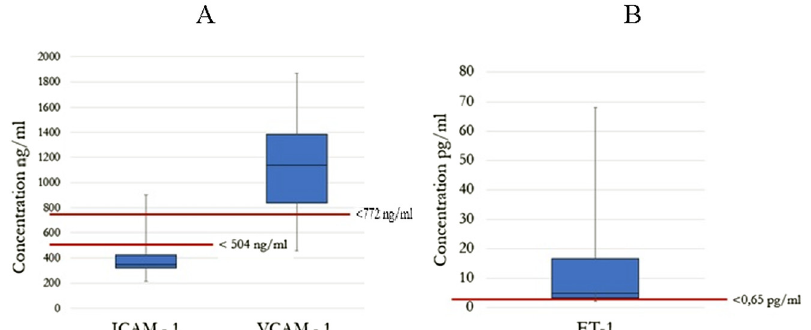
Figure 1: Comparison of soluble adhesion